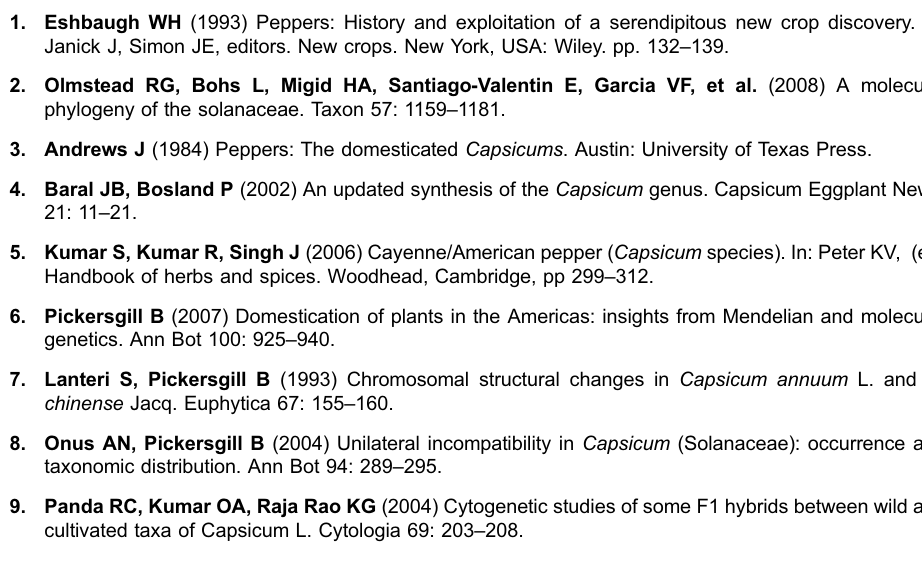
S2 Table. Microsatellite markers evaluated for the genotyping of the Capsicum spp collection. S3 Table. Total number of alleles and range of allele sizes detected in the entire collection, number of alleles and rate of polymorphism detected in each species. The two numbers in brackets represent the number of unique alleles and the number of rare alleles, respectively. ‘‘Null’’ indicates the absence of amplification. S4 Table. PIC values of 39 SSR markers on the entire collection and in each species. ‘‘Null’’ indicates the absence of amplification and ‘‘M’’ the absence of